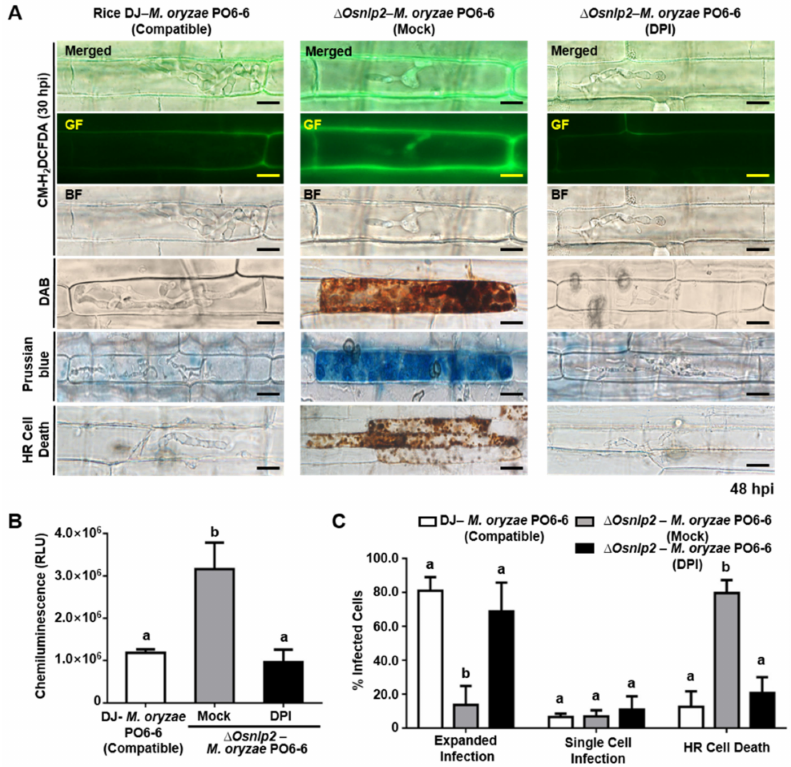
Figure 7. The NADPH oxidase inhibitor diphenyleneiodonium (DPI) suppresses the accumulation of ROS and ferric ions and HR cell death in ∆ Osnlp2 leaf sheaths infected with virulent Magnaporthe oryzae PO6-6. ( A ) Inhibition of ROS and ferric ion accumulation and HR cell death in infected rice cells treated with 5 µ M DPI. Leaf sheaths of rice DJ and ∆ Osnlp2 mutant line #4-2 were inoculated with M. oryzae PO6-6. ROS accumulation was detected by CM-H 2 DCFDA and DAB staining, and ferric ion (Fe 3+ ) accumulation was visualized by Prussian blue staining. The images shown were taken using a fluorescence microscope (Zeiss equipped with Axioplan 2) with bright field or GF filters (Ex/Em: 488 nm/505–550 nm wavelength). BF, bright field; GF, green fluorescence; hpi, hours post inoculation. Scale bars = 10 µ m. ( B ) ROS quantification in infected rice leaf sheaths treated with 5 µ M DPI. ROS quantities in rice cells were determined by a chemiluminescence assay. Values are means ± SD of relative luminescence units (RLU) ( n = 10) from different rice sheath discs. ( C ) Quantification of infection types in rice leaf sheaths treated with 5 µ M DPI. The cell numbers of different infection types were counted at 48 hpi using a light microscope. The percentages of infected cells are presented as means ± SD from the cell numbers of infection types in leaf sheaths of different rice plants ( n = 4). Different letters above the bars indicate significantly different means as determined by the least significant difference (LSD) test ( p <